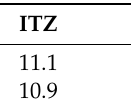
Table 4. Volume fractions of phases in corroded mortar